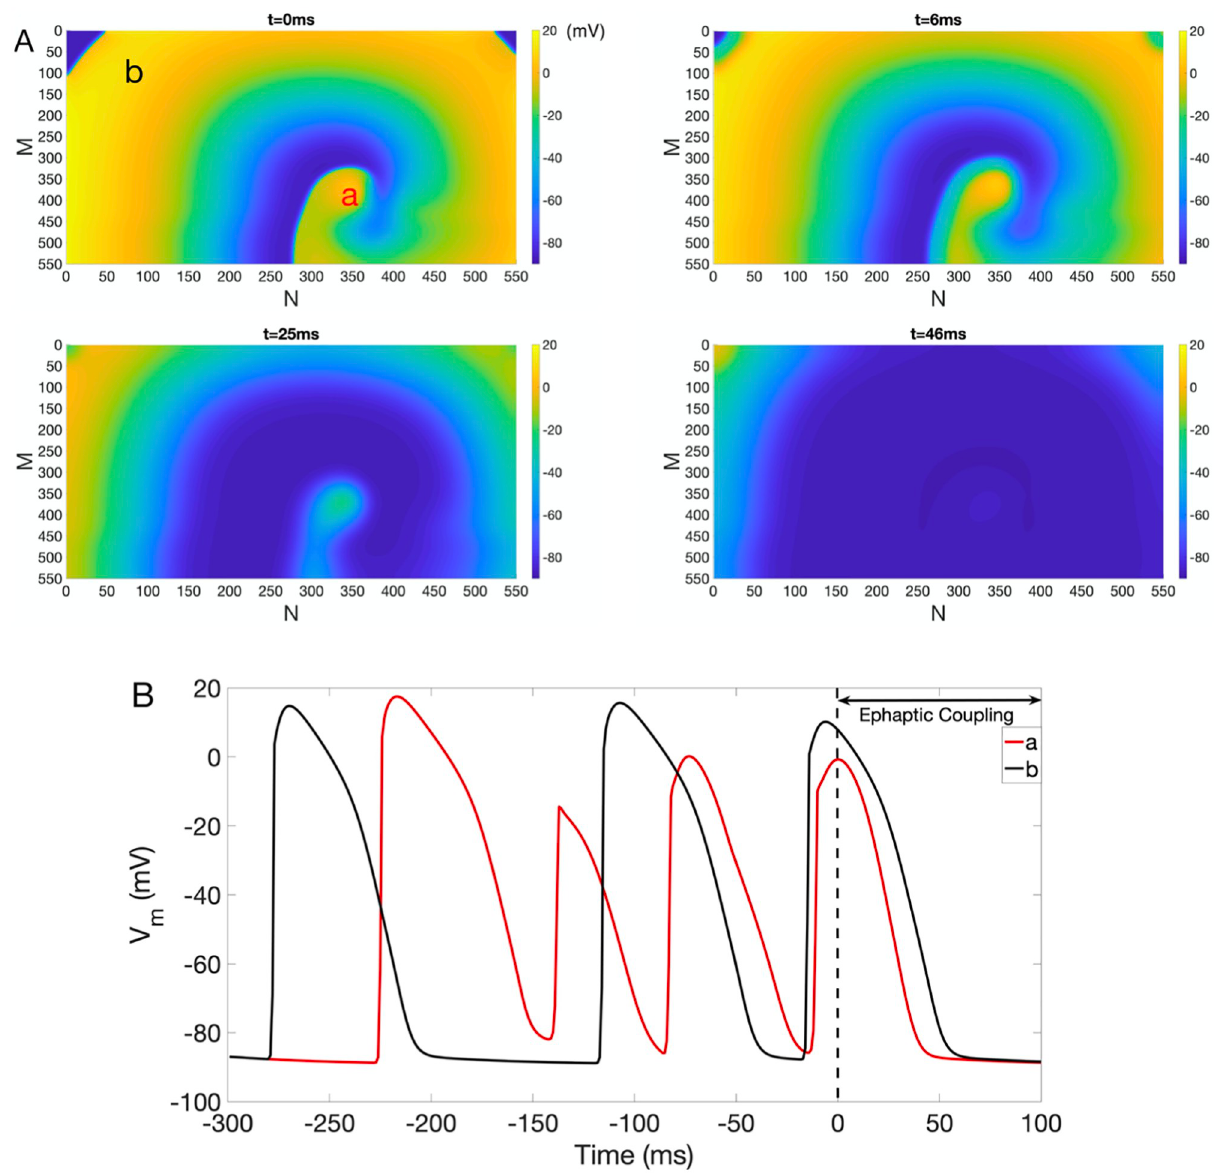
Fig 3. Inhibition of reentry in NZ under homogeneous EpC. (A) Suppression of reentry in the presence of homogeneous EpC at d cleft = 8 nm. Colorbar indicates V m (in the units of mV). Snapshots of V m at time = 0 ms, 6 ms, 25 ms and 46 ms are shown. (B) Representative V m traces at points a (red) and b